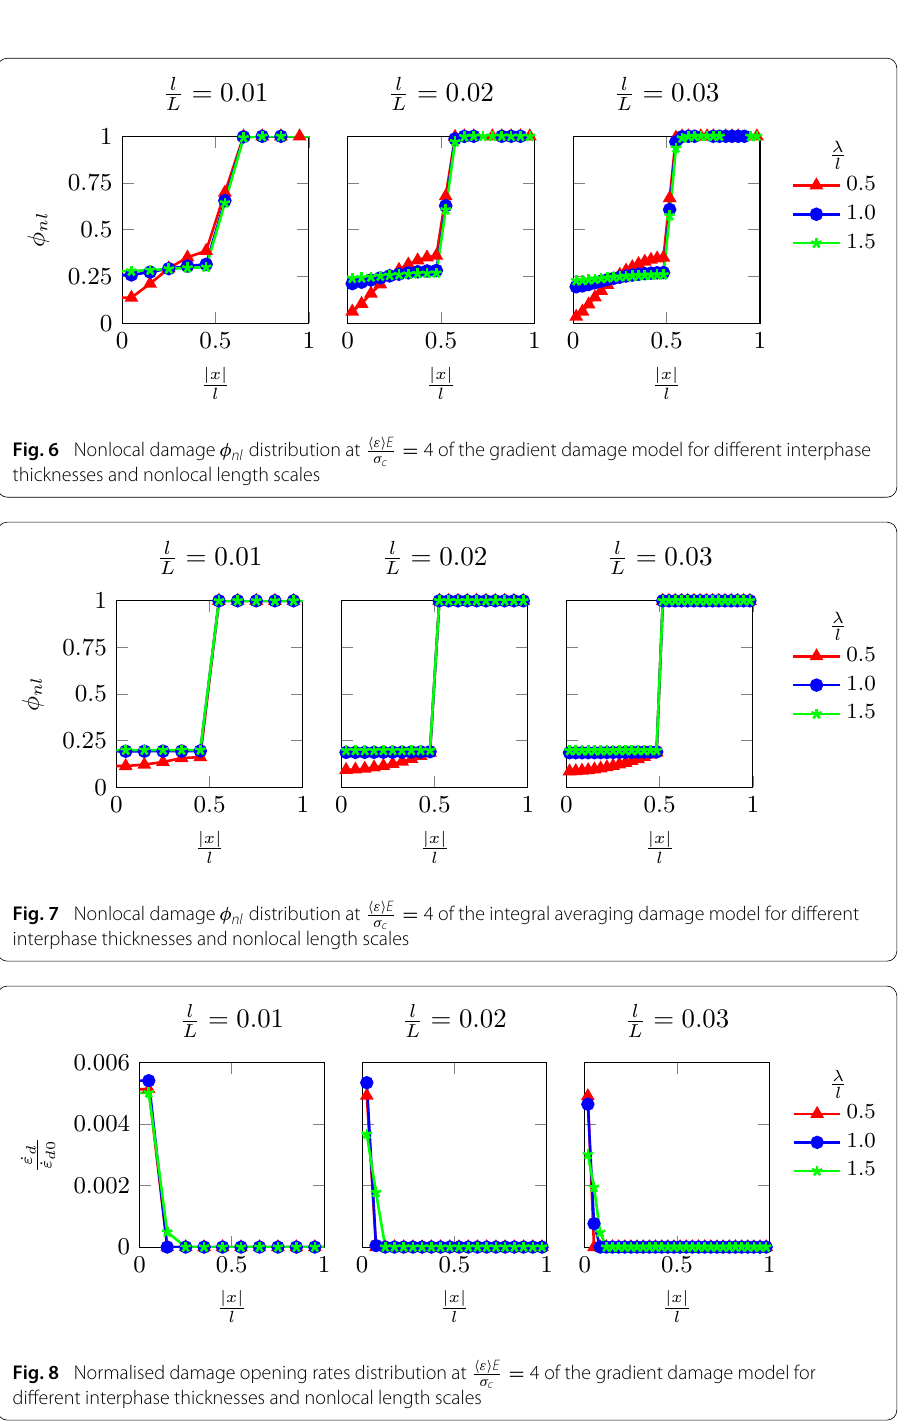
model it is also milder for the larger values of λ/ l and l / L considered, indicating that the nonlocal averaging is more effective for a large nonlocal length scale λ . In the gradient model a significant degree of localisation remains, even for the largest λ considered,